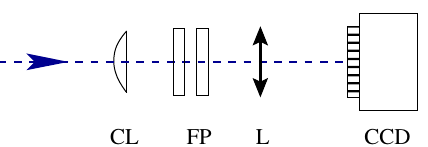
FIG. 2. System used for recording the temporal evolution of the optical spectrum. The laser beam is focused by a cylindrical lens (CL), 5 cm length, on a Fabry-Pe´rot interfer- ometer (FP) EXFO TL15, used as an etalon (Finesse > 100 , spacing 0.5 mm). The far-field interference figure is then imaged, using the lens (L) with 10 cm focal length onto a Perkin-Elmer LD3541 CCD line scan camera (512 pixels, 67 000 lines = s ).